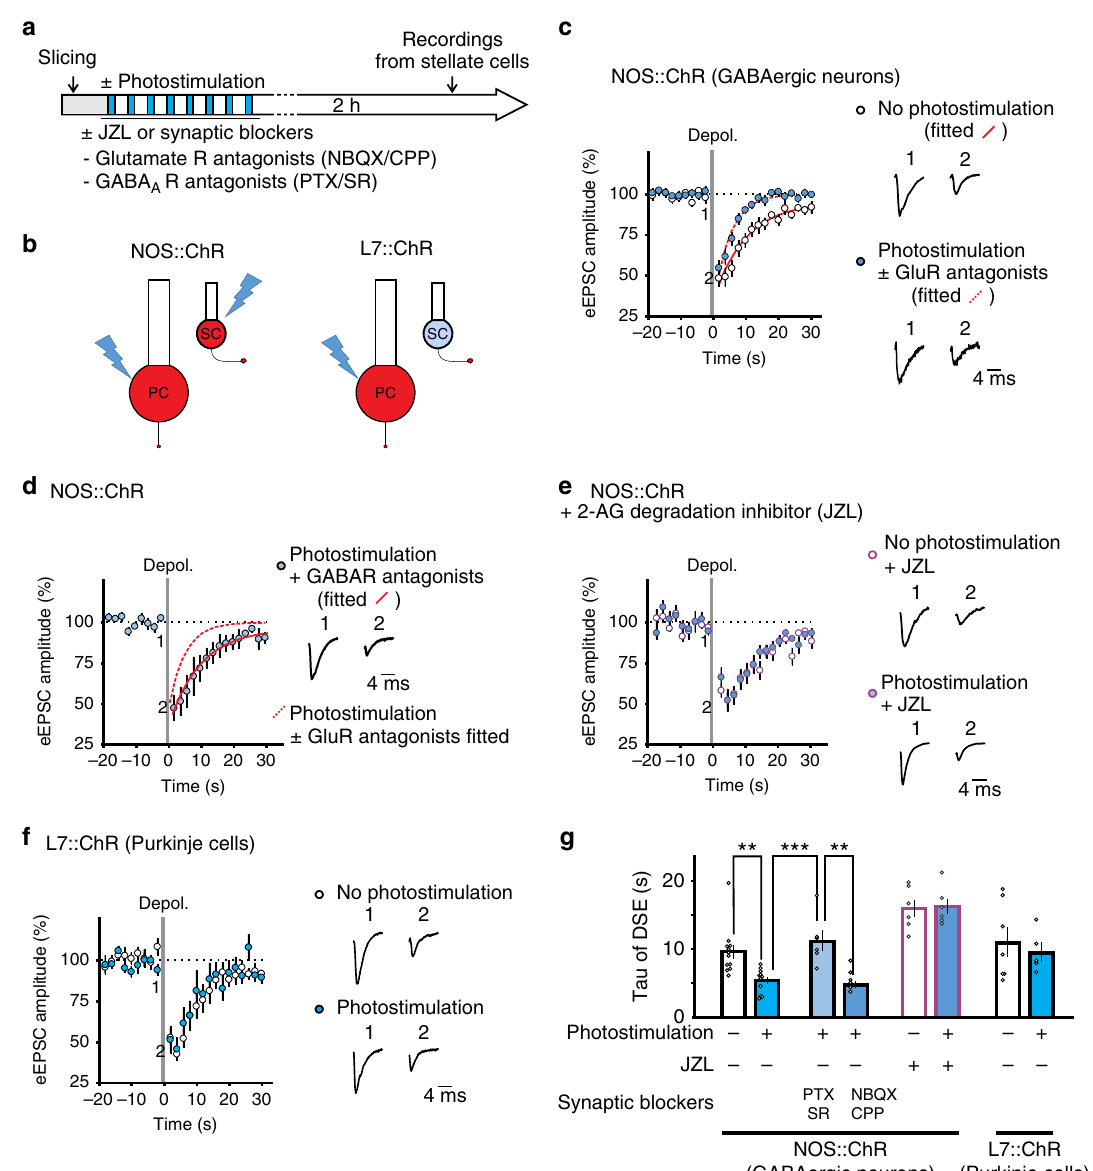
Fig. 4 Optogenetic activation of cerebellar interneurons shortens endocannabinoid signaling. a Cerebellar slices from NOS::ChR or L7::ChR mice were exposed to photostimulation and tested for DSE 2 h later. b Schematic of the cell types that express Channelrhodopsin-tomato (red) in NOS::ChR and L7:: ChR mice. c Photostimulation (± glutamate-receptor blockers, NBQX + CPP) accelerates the recovery time of DSE relative to no stimulation control ( n = 12 cells) in NOS::ChR mice. d The presence of GABA A R blockers ( n = 6 cells), during photostimulation prevented the change. e JZL 184 , a MAGL inhibitor, increased the recovery time of DSE and abolished the difference between photostimulated ( n = 6 cells) and non-stimulated cells ( n = 6 cells). f Photostimulation ( n = 5 cells) failed to alter DSE in L7::ChR mice (no stimulation n = 7 cells). g Summary of DSE recovery time (photostimulated no drug, n = 5 cells; photostimulated + NBQX/CPP, n = 6 cells). Group comparisons were obtained with two-sided unpaired t -test (*, P = 0.026; **, P = 0.006; ***, P = 0.007). Data in c – g are presented as mean values ± SEM. Detailed statistics and exact P values can be found in Supplementary Table 4 and original data in the Source Data fi